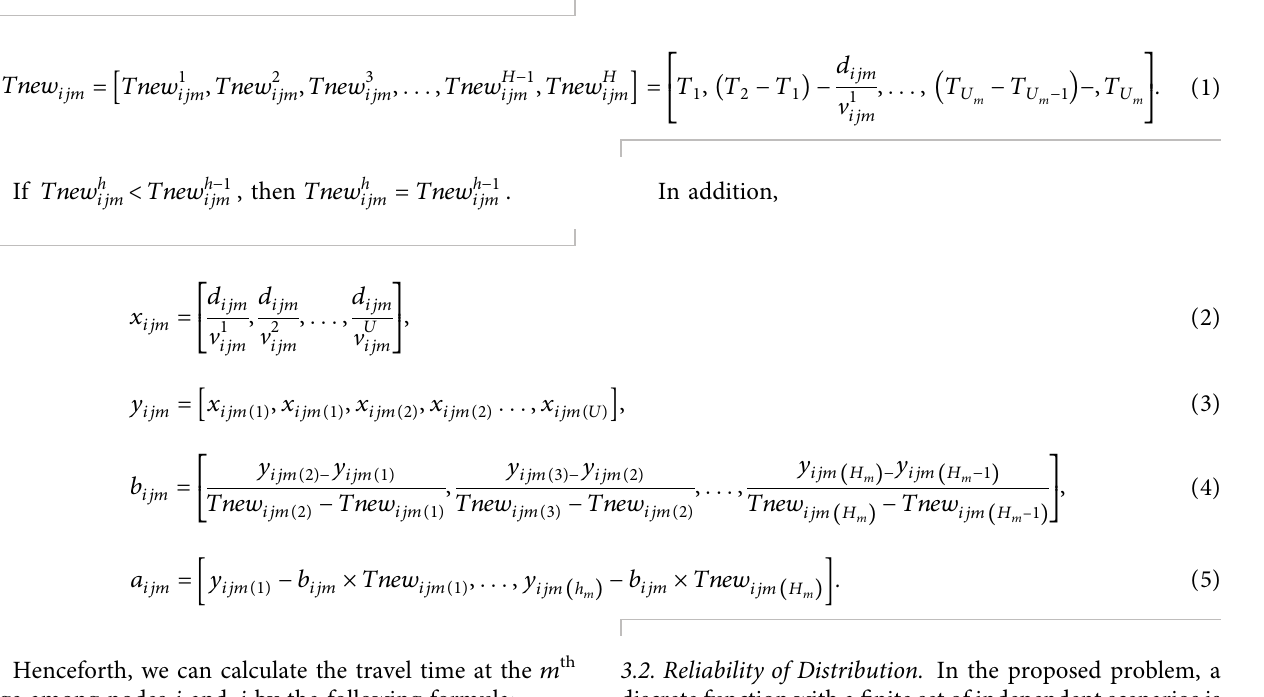
Figure 3. In this method, a vector U is defined as initial distinct intervals for the m th arc between two nodes i and j .